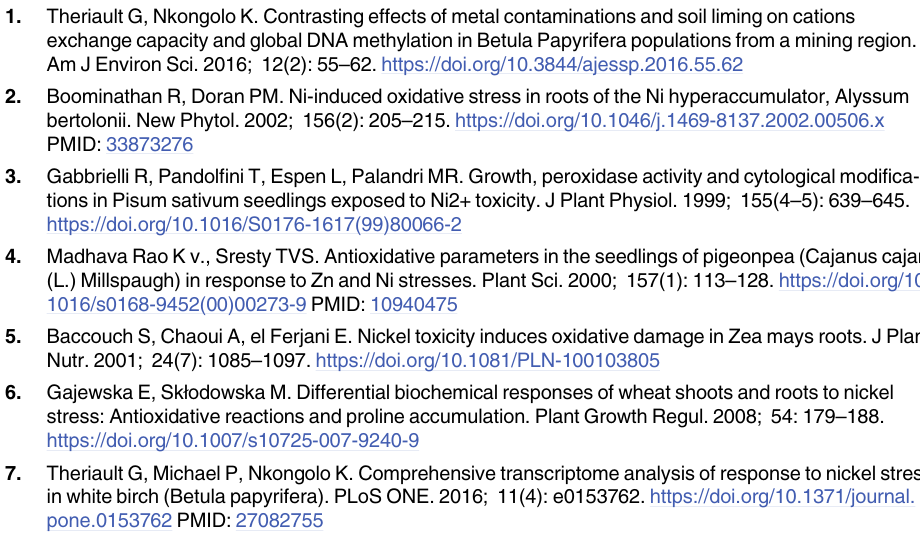
S2 Fig. Top enriched GO terms from GSEA for downregulated (negative) genes in nickel resistant genotypes when compared with nickel susceptible genotypes.